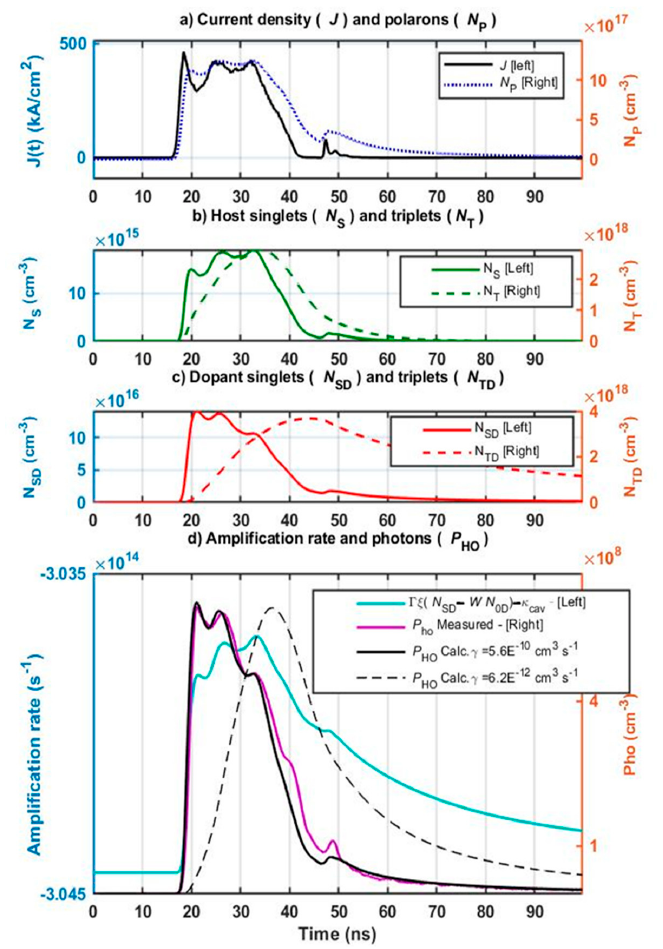
10 of 17 set of Equations (1)–(8) with model parameters from Table 1, except for the fitted parameters given in Table 2. The results are plotted in Figure 3, where Figure 3d shows the measured and simulated photon densities in one plot for comparison. The values for γ and κ (cid:2888)(cid:2889)(cid:2908)(cid:2904) in Table 2 are the result of detailed fitting of the shape of the simulated photon response to the measured data. Variations in κ (cid:2888)(cid:2889)(cid:2908)(cid:2904) values mainly affect the leading edge and the maximum of the photon response. The black dashed curve in Figure 4d is the simulated photon density if the literature value γ = 6.2 × 10 − 12 cm 3 s − 1 instead of the fitted value in Table 2 is taken. The nearly two orders of magnitude larger value for γ stems from the Poole-Frenkel effect for the mobility due to the internal electric field, induced by the high voltage of 45 V applied in the experiment (see Section 3.1.1). The validation of our model for a sub-threshold case is important, since it validates the